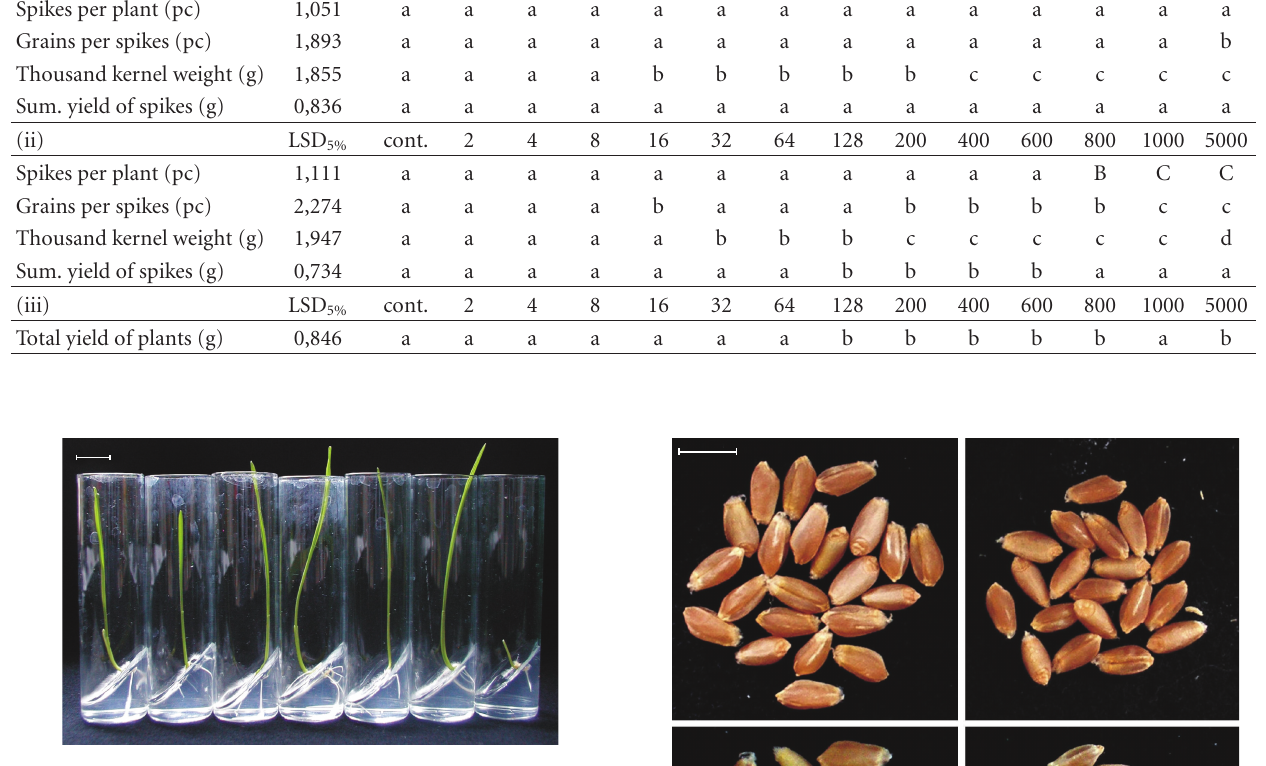
Figure 3: Germination of mature embryos of the transgenic spring wheat line “T-124” on media containing 0, 200, 400, 600, 800, 1000, and 5000 mg · L − 1 glufosinate ammonium (from left to right) on the seventh day of culture. bar ∗ 1.0 cm.